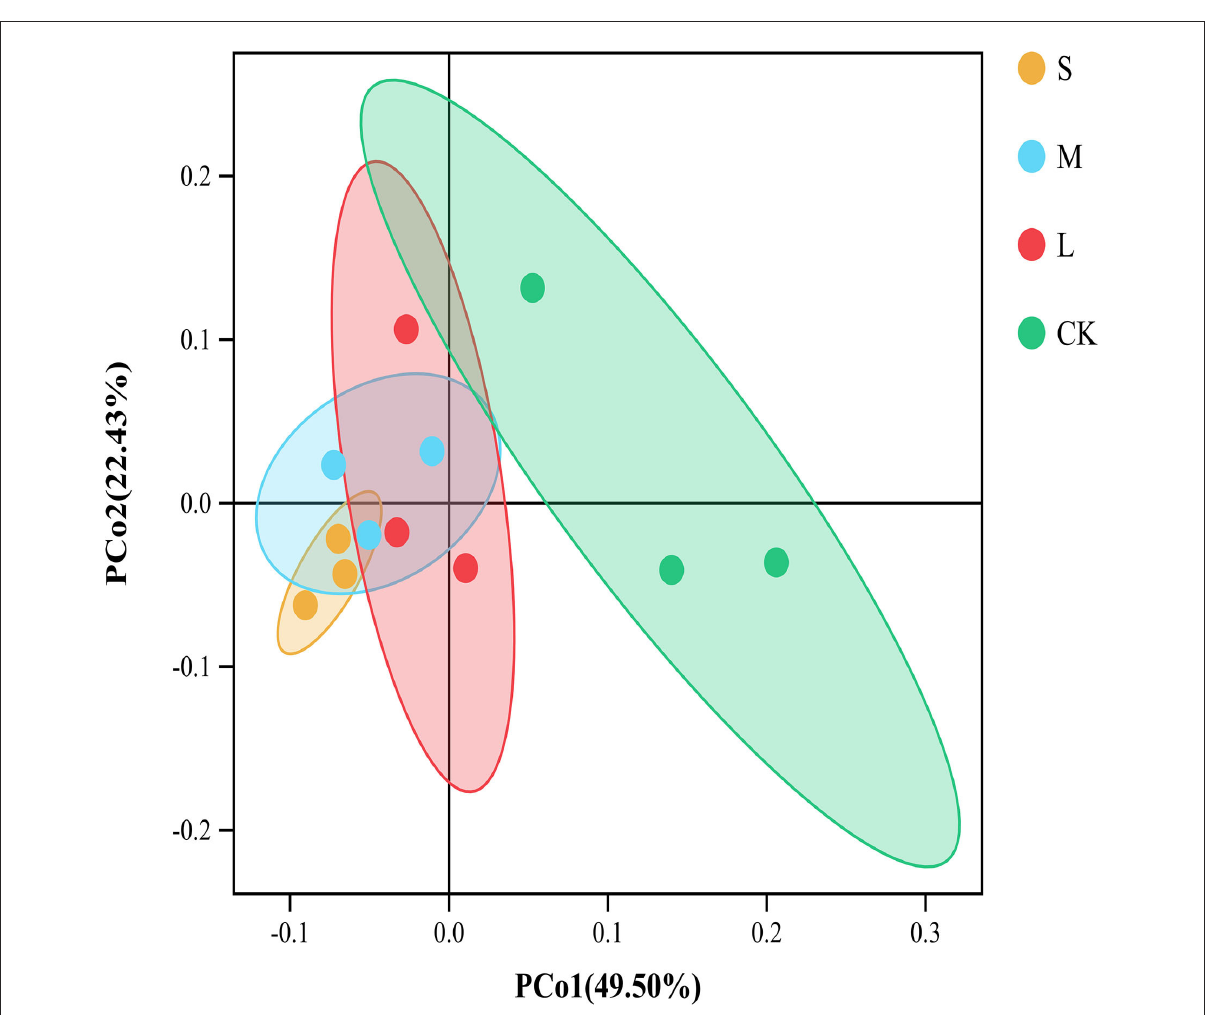
FIGURE2 Principal coordinate analysis (PCoA) of the soil bacterial community based on Bray–Curtis distance among different groups. The ellipses represent the 95% confidence interval. “S” stands for small gaps; “M” stands for medium gaps; and “L” stands for large gaps.